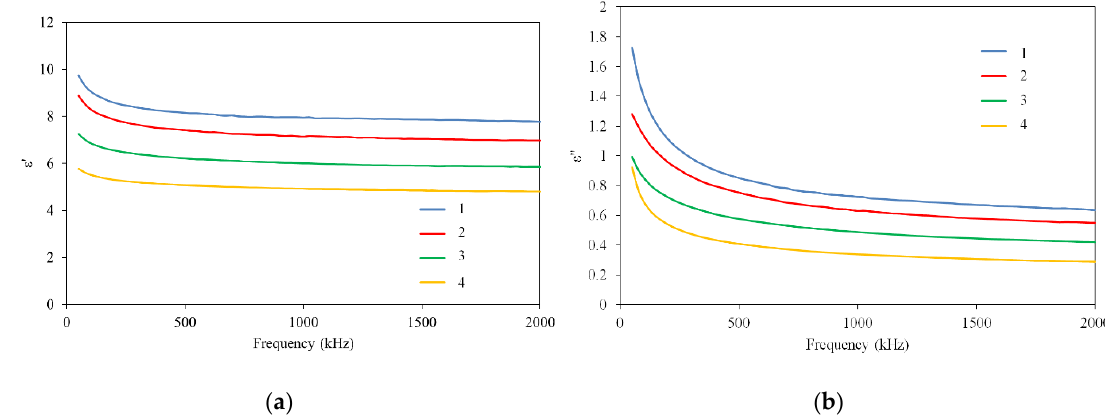
Figure 5. Frequency dependence of the complex dielectric permittivity of the gelatin–PANI composite films: ( a ) real part of dielectric permittivity; ( b ) imaginary part of dielectric permittivity; 1 – gelatin; 2 – 22%-PANI-GEL; 3 – 36%-PANI-GEL; and 4 – 59%-PANI-GEL.